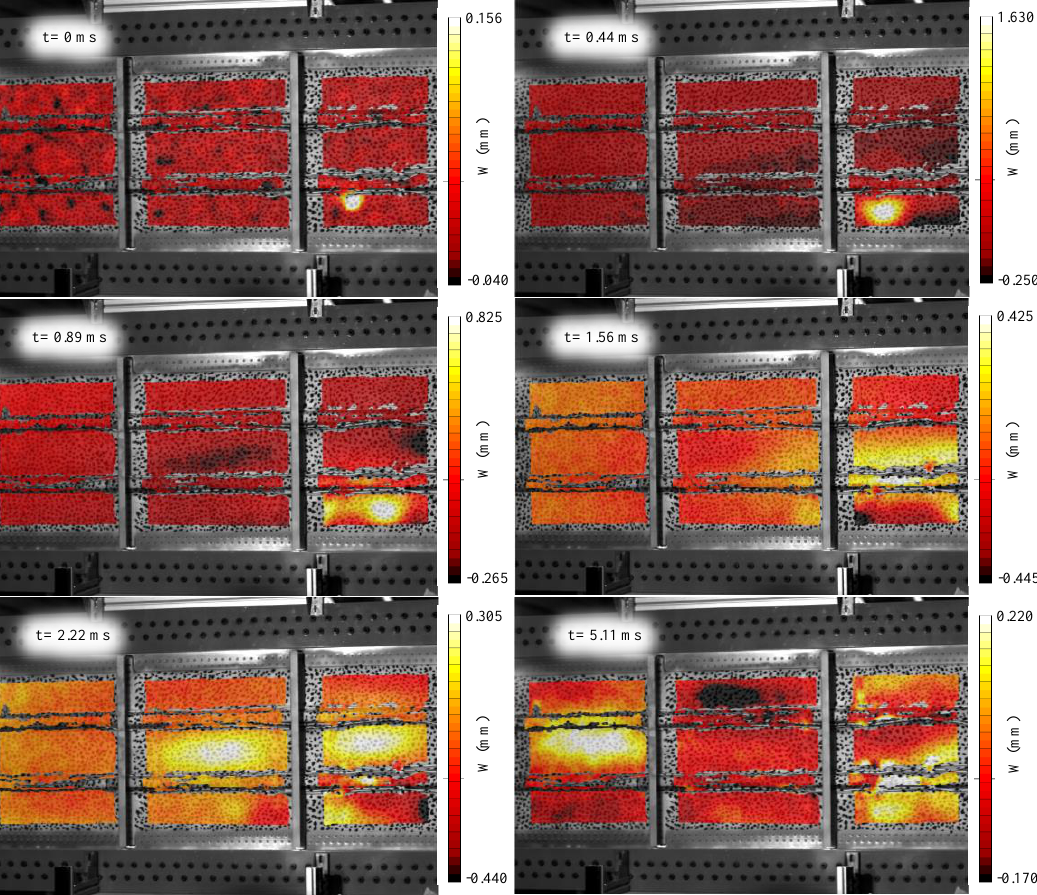
Figure 5. Evolution of the out-of-plane displacements after the impact at different time instants with respect to the very first contact.